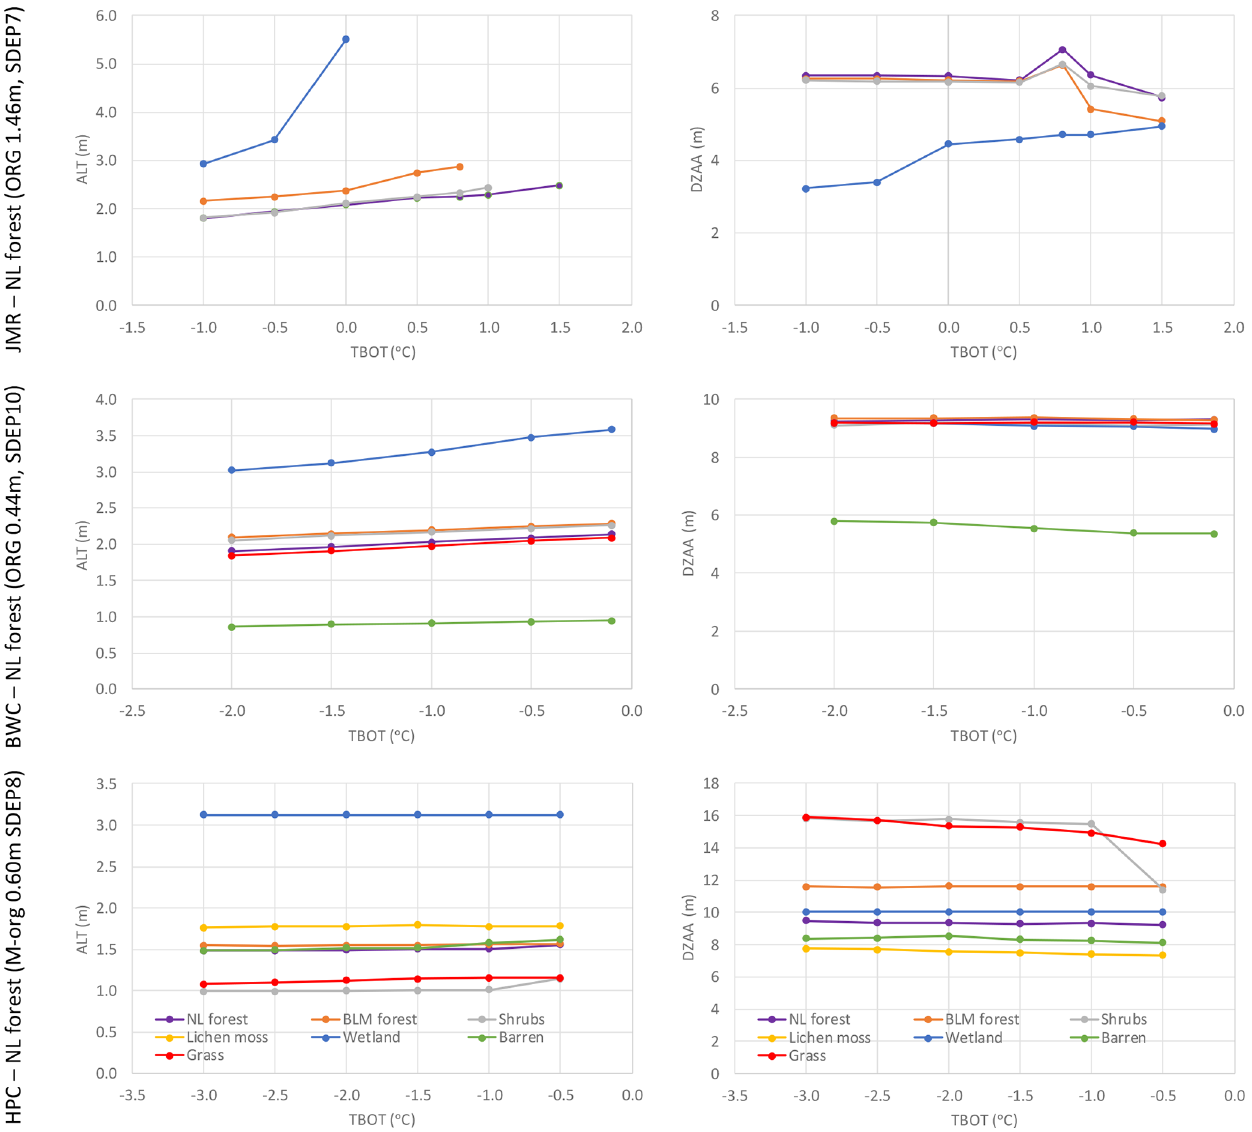
Figure 14. Impact of TBOT on the average simulated ALT and DZAA for different GRUs at the three study sites over the 1980–2016 period.